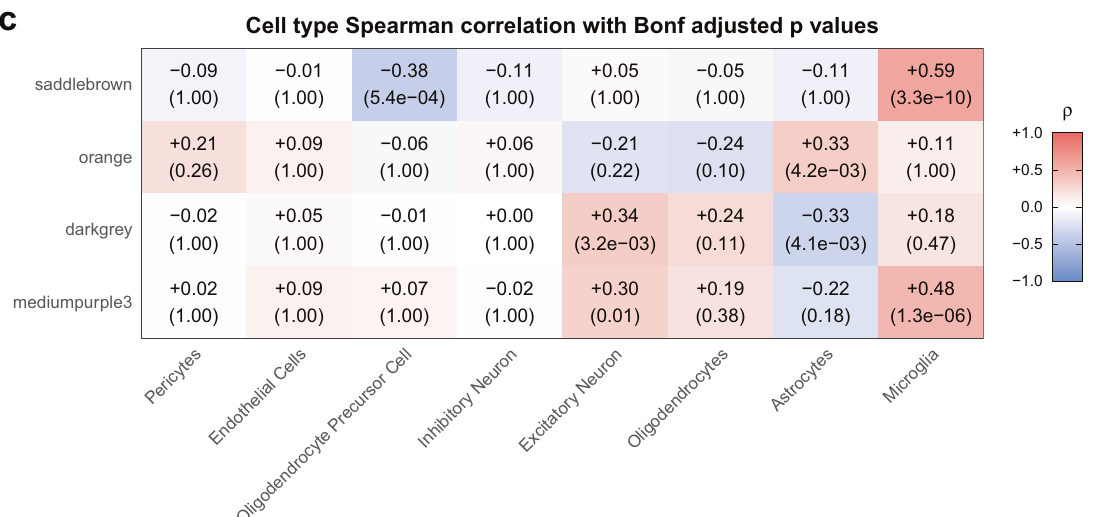
Fig. 3 Gene expression modules correlate with AD pathology in the setting of subjective cognitive impairment. a , b Consistent with the single-gene analysis, WGCNA shows that only three modules ( saddlebrown , orange , and darkgrey ) correlate signi fi cantly with β -amyloid ( a ) and tau ( b ) when all samples ( n = 106) are considered (red bars on left; see Supplementary Data 2 for the correlations for all WGCNA modules from this analysis and Supplementary Data 3 for the list of genes in key modules in this paper). Subjective cognitive status strongly in fl uences how microglial modules correlate with β -amyloid and tau pathology (green and blue bars). When we removed all samples with AD pathology from our cohort that reported subjective cognitive impairment (leaving samples with AD pathology without subjective cognitive impairment and all non-pathology specimens; the resulting n = 66), this abolished the signi fi cant correlation of the modules with AD pathology (green bars). In contrast, when we do the converse (i.e., remove all samples with AD pathology from our cohort that do not report subjective cognitive impairment, leaving samples with AD pathology with subjective cognitive impairment and all non-pathology specimens; the resulting n = 80), our gene expression modules continue to correlate with AD pathology in the remaining biopsies (blue bars). In fact, one module that was previously not signi fi cant becomes signi fi cant ( mediumpurple3 ). a , b are FDR adjusted using the Benjamini – Hochberg procedure across all 58 modules in our WGCNA analysis — dotted line in a , b is FDR = 0.1; all correlations are Spearman ’ s correlations with two-sided signi fi cance. See Supplementary Table 1 for a full breakdown of the cognitive status of all samples in our cohort. c The modules in a , b were correlated with cell-type-speci fi c gene lists (using human single-nucleus RNA-seq data 21 ). While saddlebrown and mediumpurple3 are clearly microglial, darkgrey and orange are more weakly neuronal and astrocytic, respectively, by Spearman ’ s correlation (each row is separately Bonferroni adjusted, with adjusted two-sided p values in parentheses below Spearman ’ s correlations; see Supplementary Fig. 3 for Fisher ’ s exact test enrichment of these modules with cell-type-speci fi c gene lists and Supplementary Data 5 for all Spearman ’ s correlations and enrichment values and p values for these modules with different cell